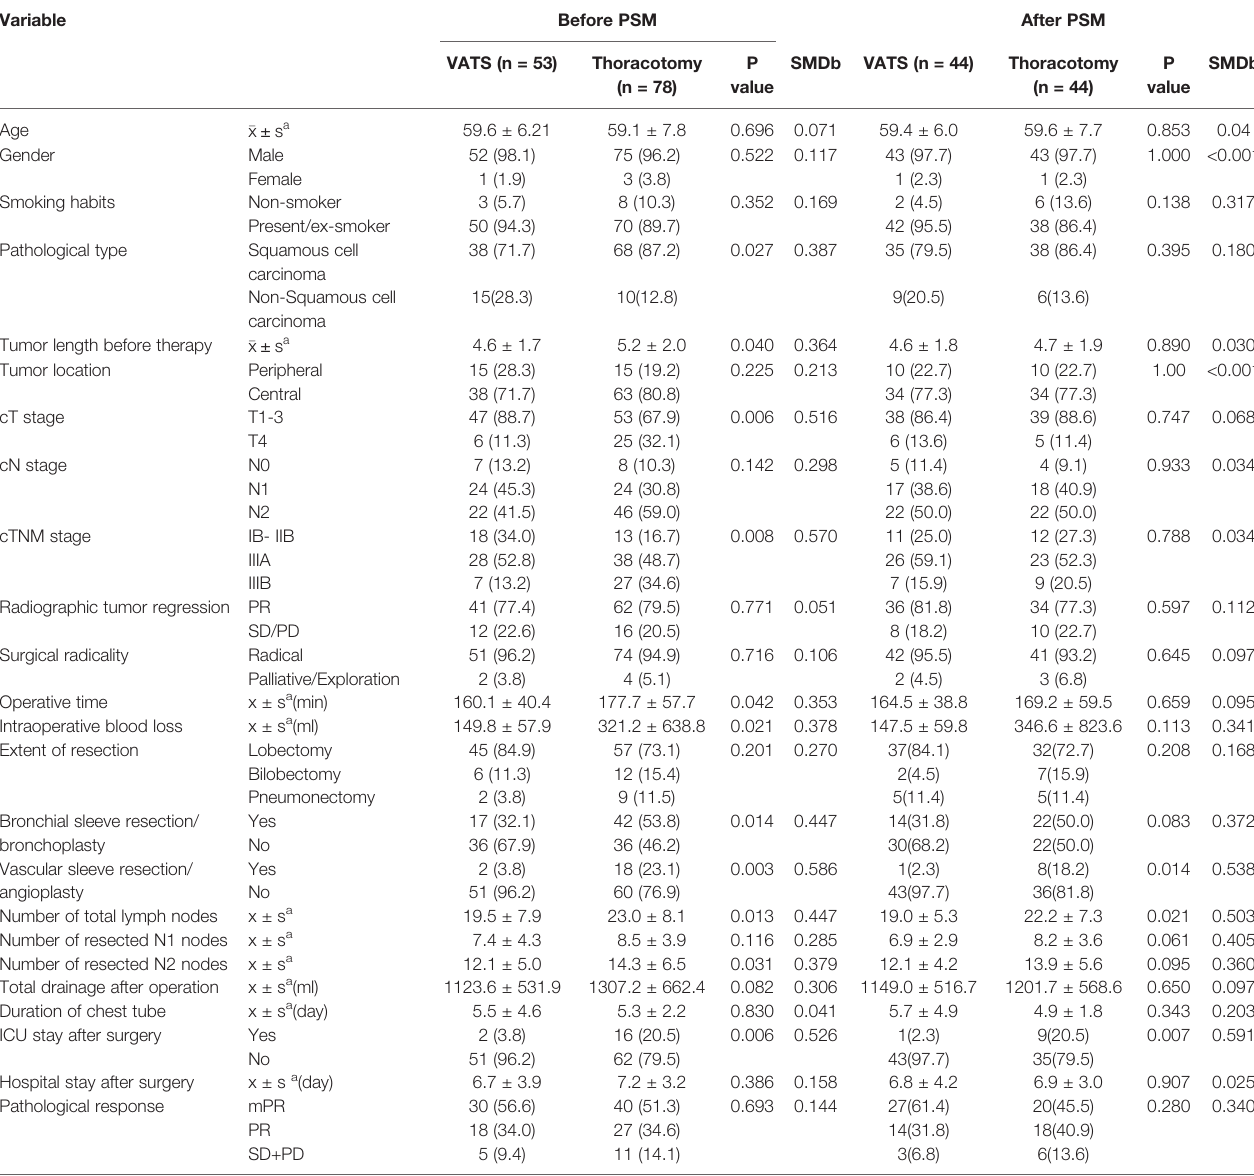
TABLE 3 | Comparison of tumor characteristics for 131 NSCLC patients received pulmonary resection via VATS or thoracotomy. Variable Before PSM After PSM VATS (n =